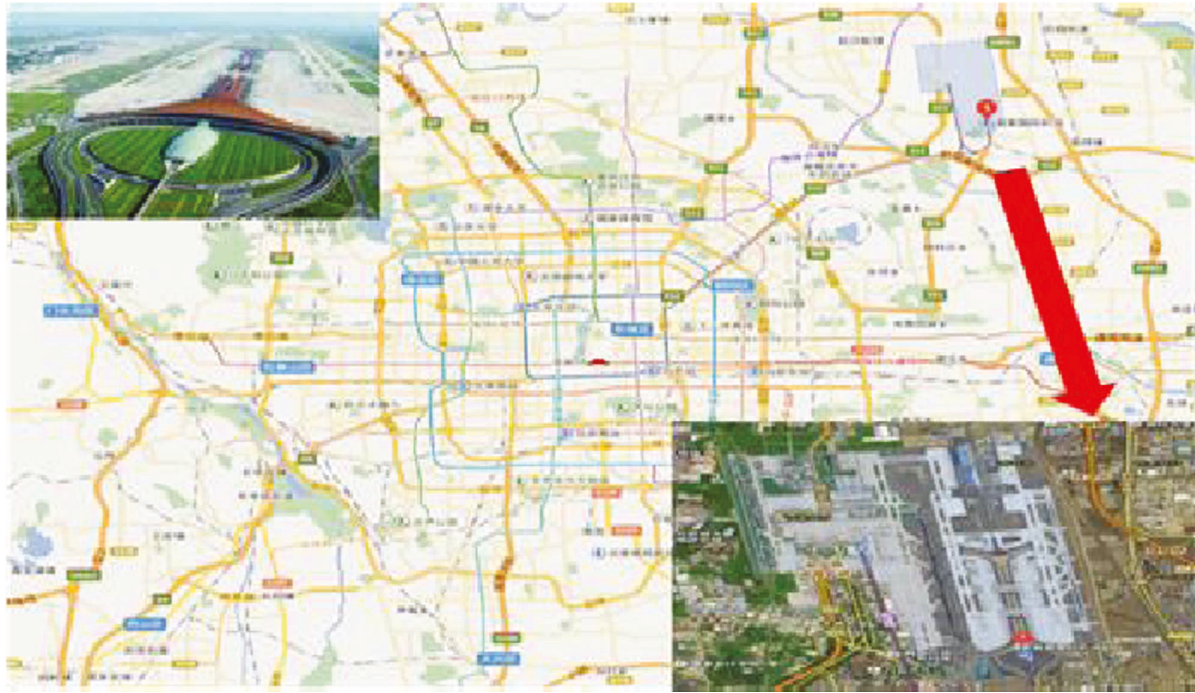
Figure 5: Beijing Capital International